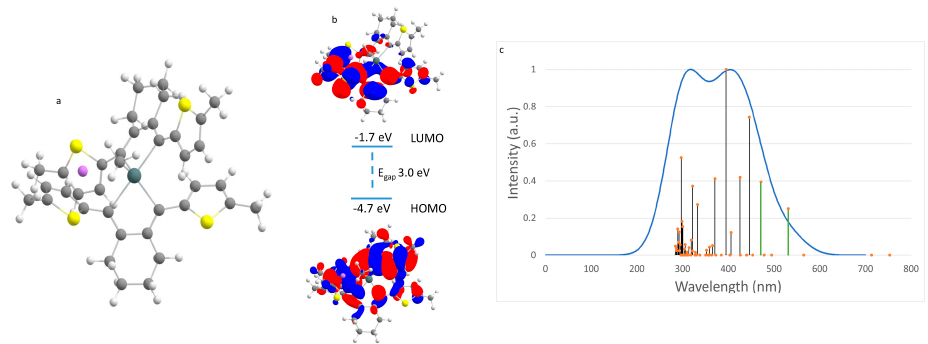
Figure 6. ( a ) Optimised geometry of pentaorganostannate 5 ; ( b ) FMOs of pentaorganostannate 5 and energies; ( c ) Calculated TD-DFT absorption spectrum of pentaorganostannate 5 . Direct HOMO → LUMO transitions are highlighted in green.